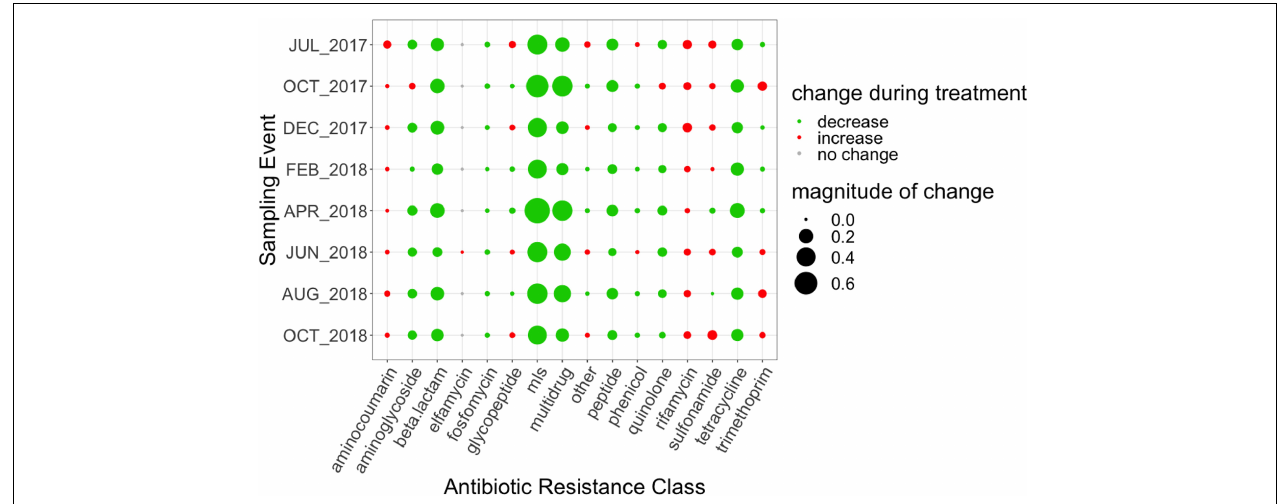
FIGURE 2 | Magnitude of change (based on absolute difference) between influent and secondary effluent for each ARG grouped by antibiotic resistance class. Change was calculated as the difference between the relative abundance of the secondary effluent and the relative abundance of the influent. MLS indicates resistance to macrolides, lincosamides, and streptogramins.